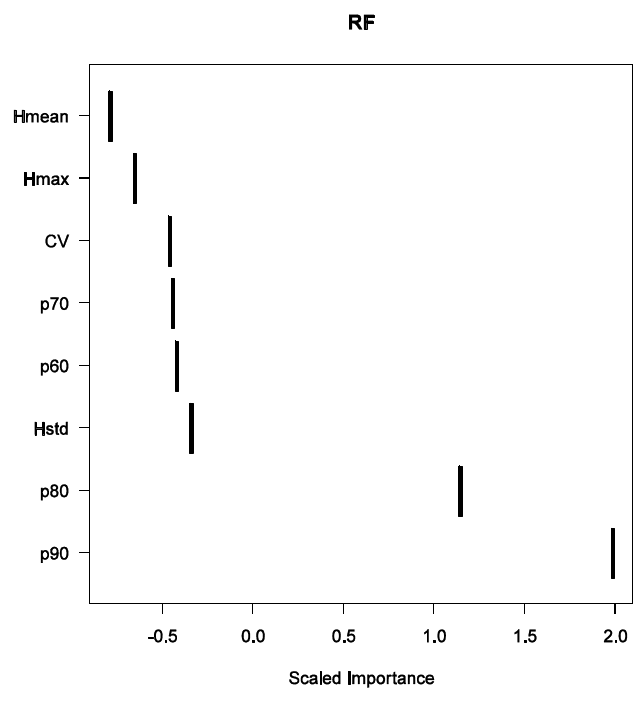
Figure 2. Scaled Importance in Random Forest run in classification of defoliation.